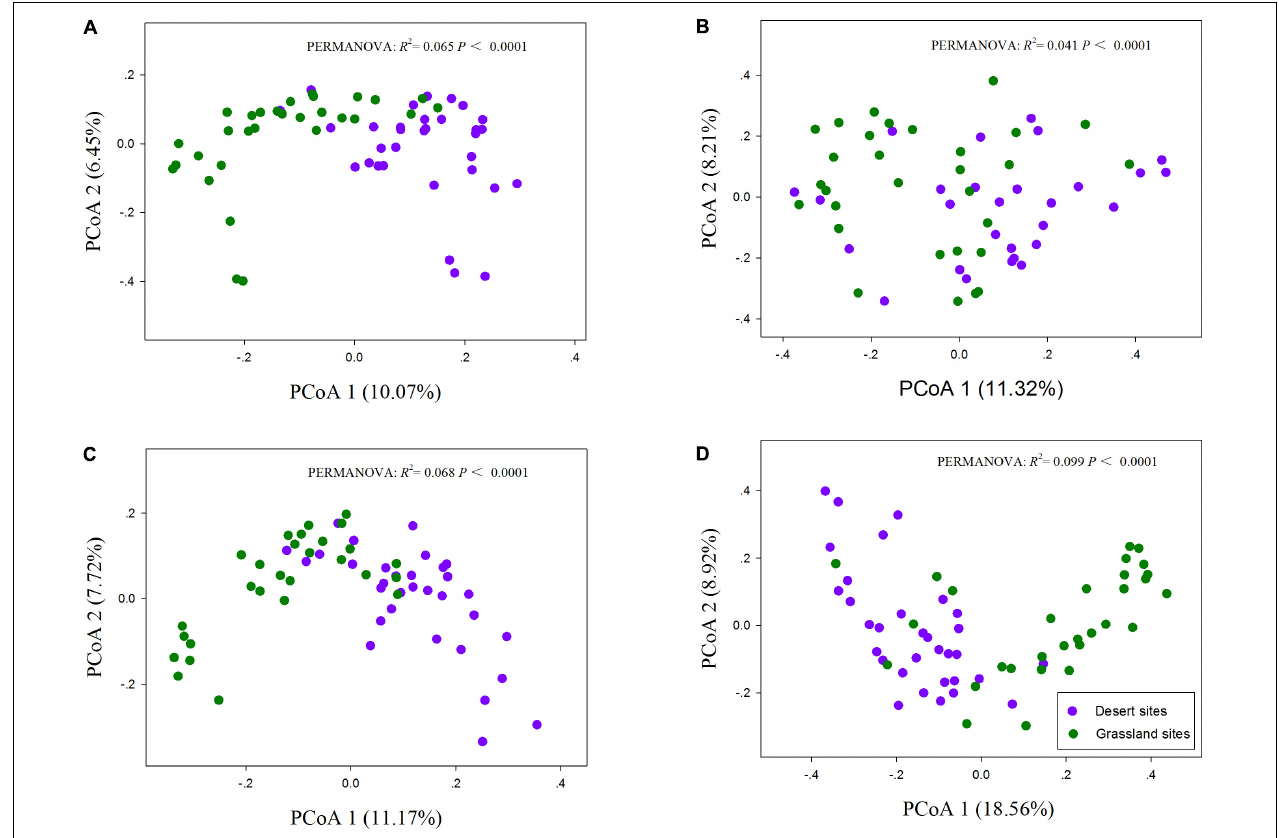
FIGURE 2 | The principal coordinate analysis (PCoA) of total (A) , AM (B) , saprotrophic (C) , and pathotrophic (D) fungal communities.